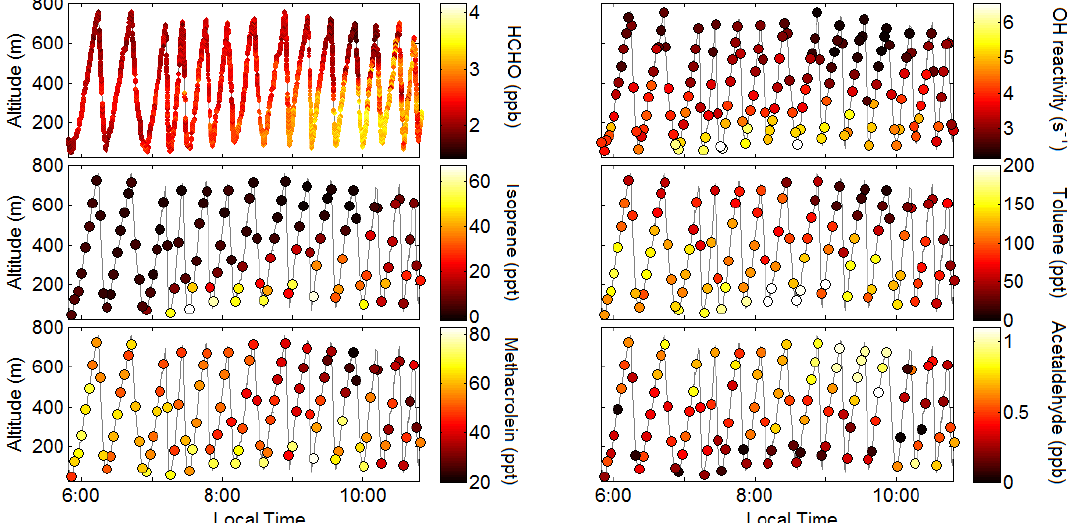
Figure 2. Flight pattern colored by selected